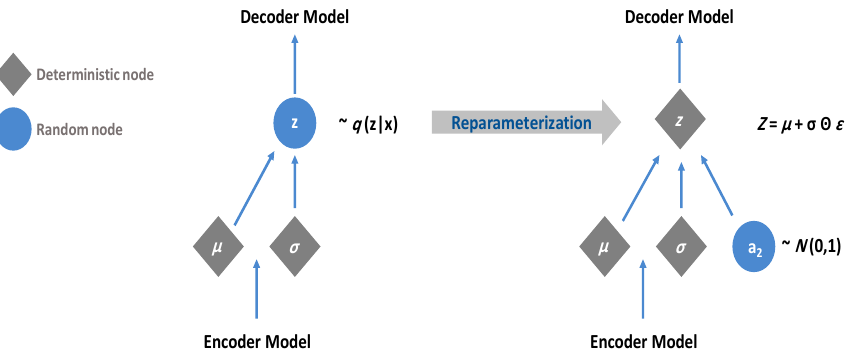
Figure 9. A representation of a variational autoencoder with reparameterization [52].